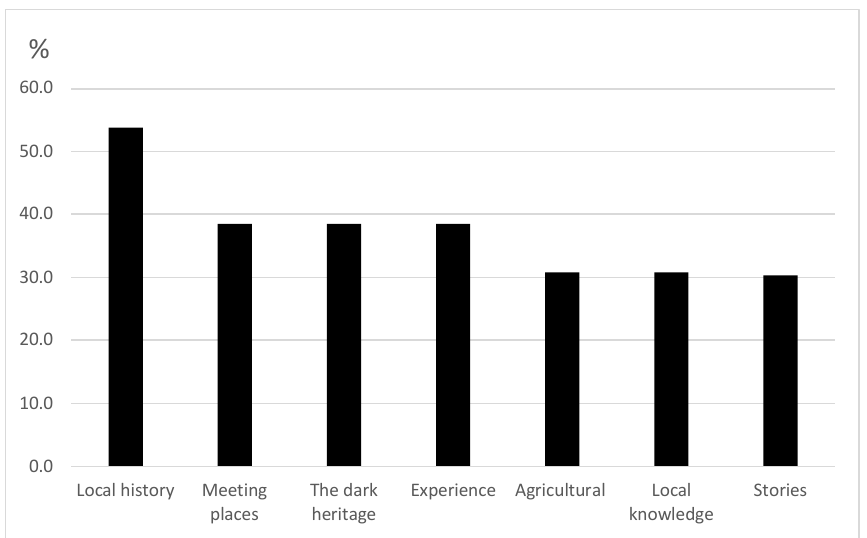
Figure 3. The x -axis shows the seven most important historic and cultural landscape dimensions that need more focus in the planning process (measured as percentage, y -axis). See also Table 1, closed-ended questions.